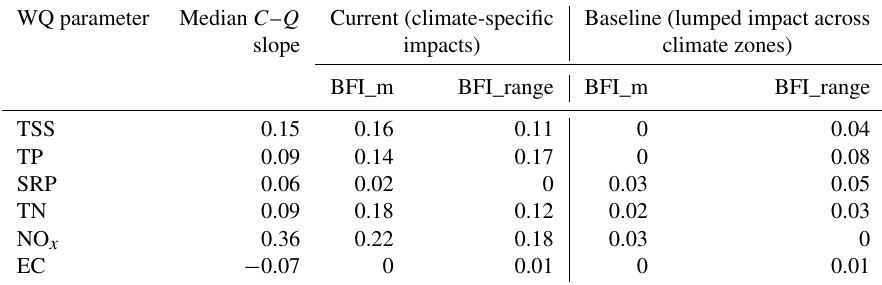
Table 1. Performance of the BFI-based C – Q models – the columns show four alternative model structures with BFI_m or BFI_range as the key predictor and with the impacts of baseflow contribution considered as lumped or specific to individual climate zones. The rows show results for individual water quality parameters. All model performances are summarized by R 2 , which quantifies the percentage of variance in C – Q slopes explained by the BFI-based